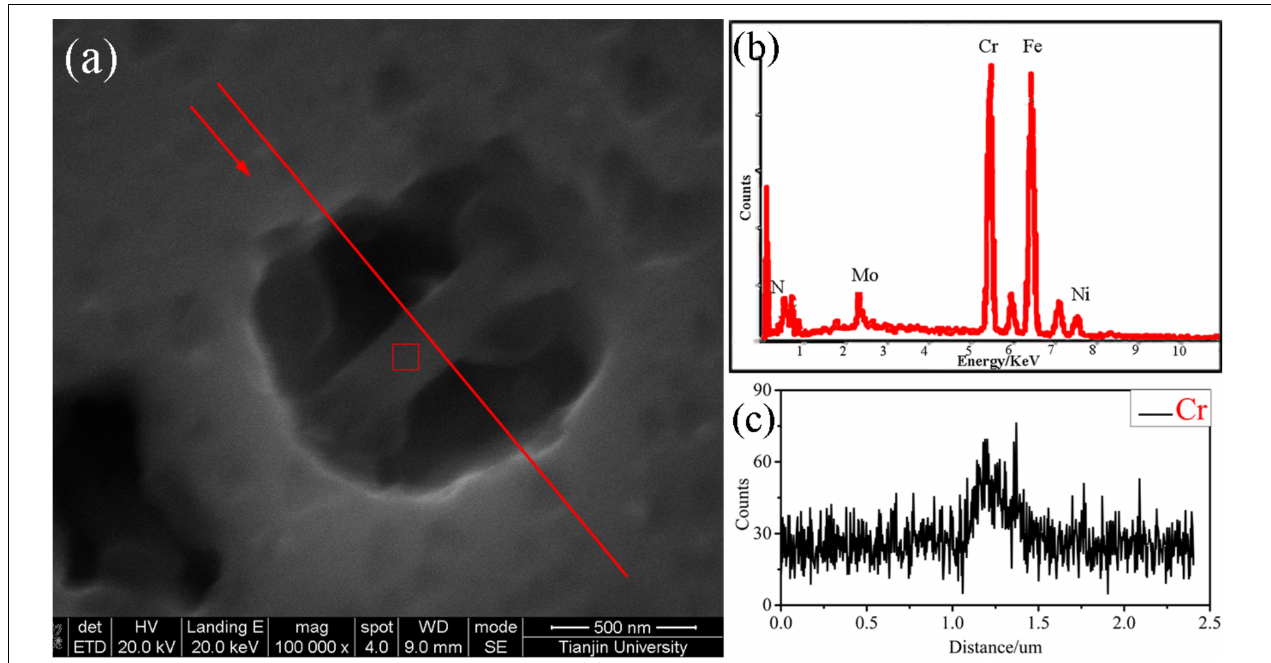
FIGURE 14 | The Cr 2 N in the pits observed by SEM: (a) pits morphologies, (b,c) corresponding EDS point scanning and line scanning results.